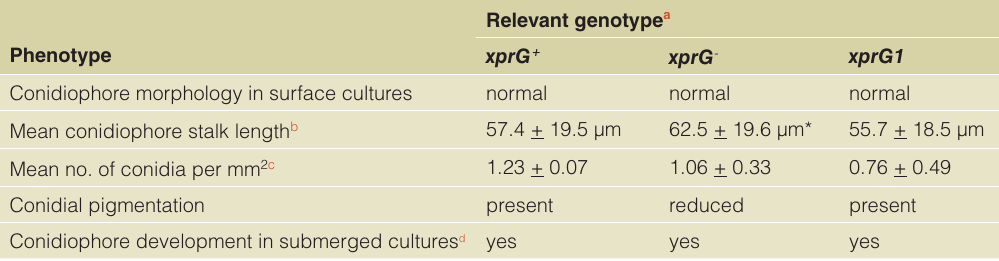
Table 4. Conidiophore development in xprG